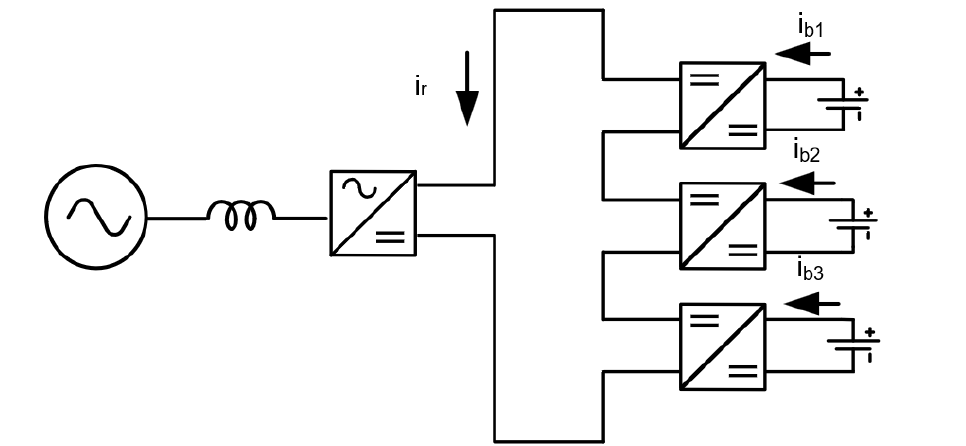
Figure 1. Modular Cascaded Charger (MCC).